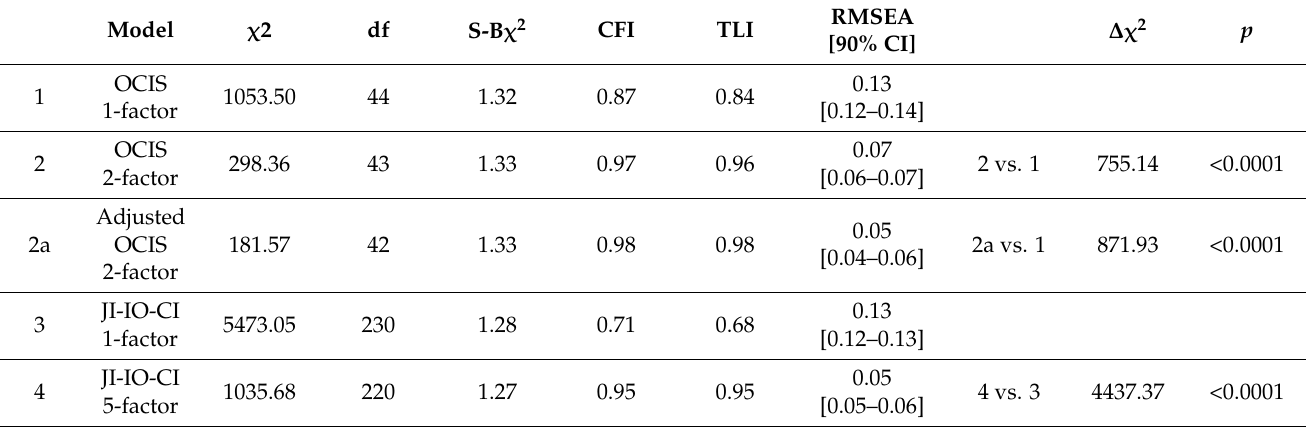
Table 2. Model fit indices for factorial and construct